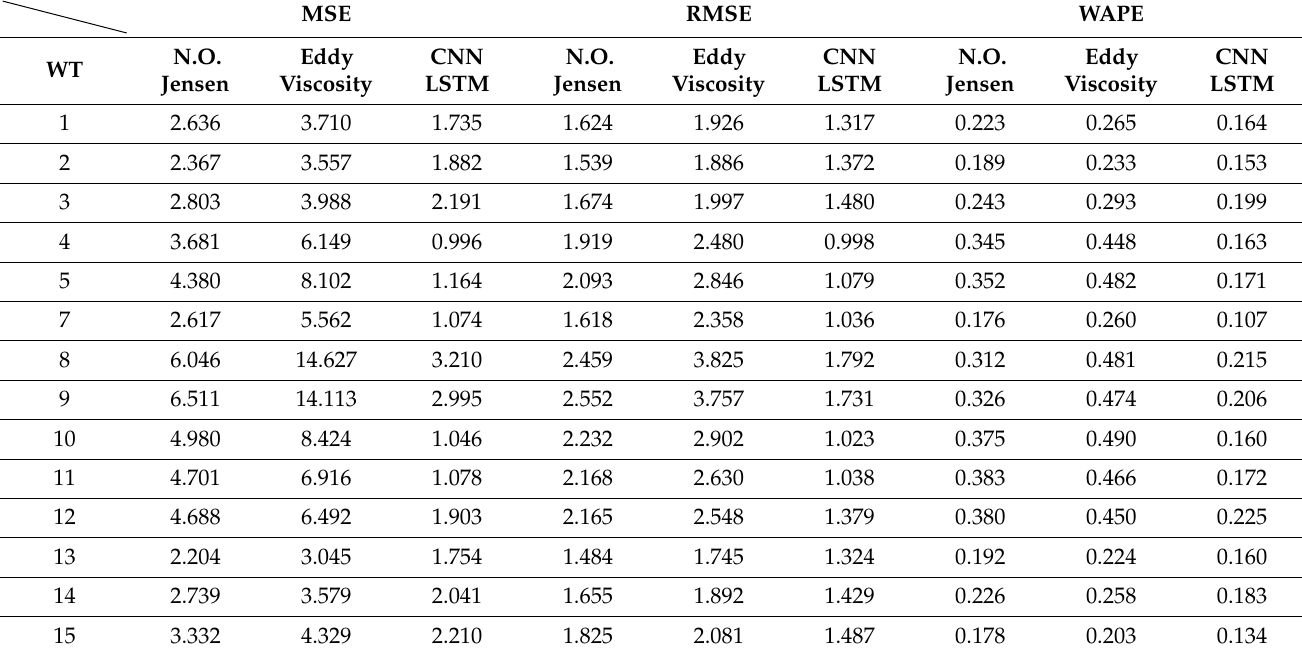
Table 7. Comparison of wake error caused by No. 6 wind turbine.